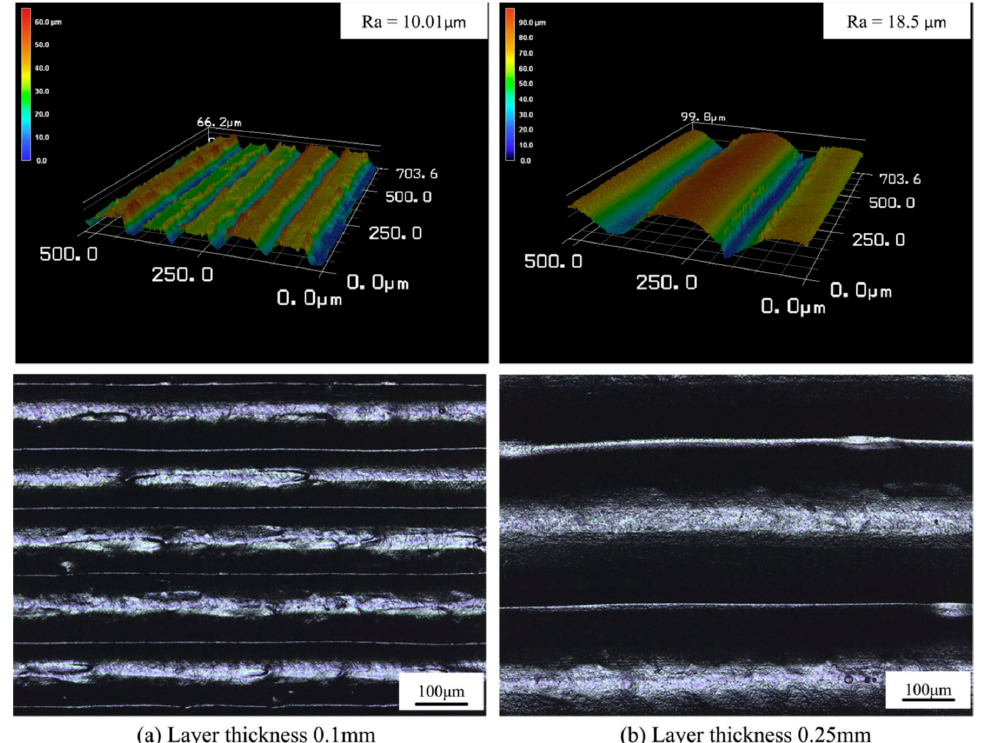
Figure 8. Surface morphology of PEEK samples printed in the vertical direction: layer thickness of ( a ) 0.1 mm, and ( b ) 0.25 mm [84].